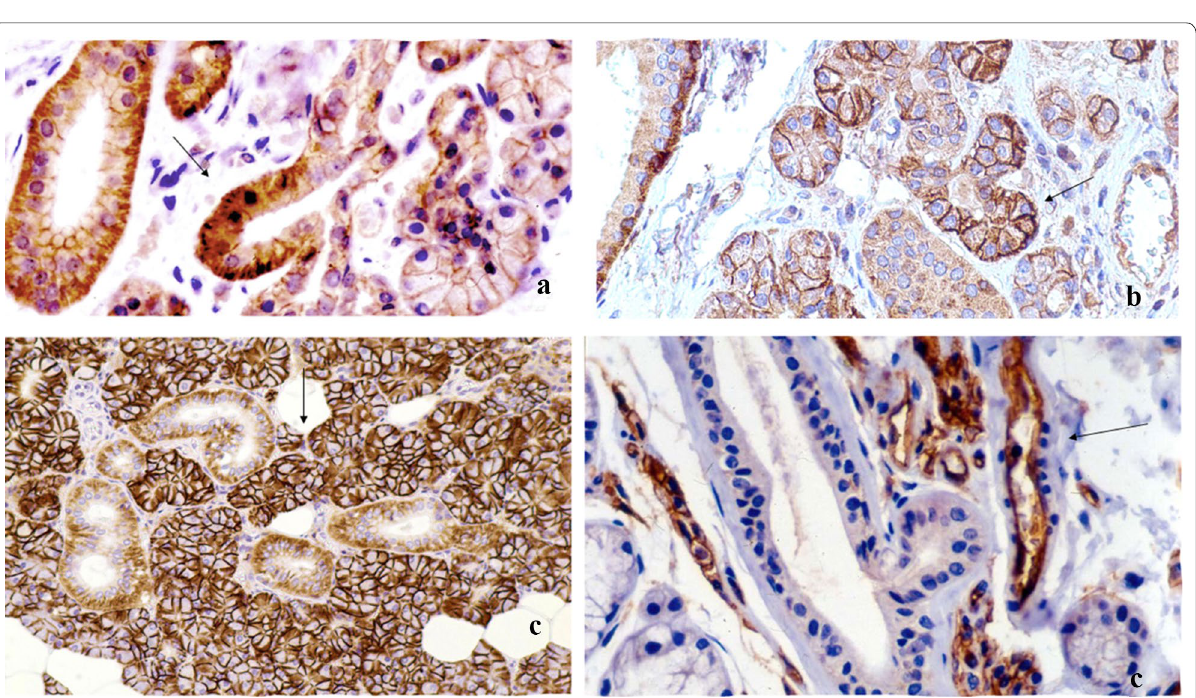
Fig. 1 Cell adhesion molecules in normal salivary gland tissue. a Desmoglein-2 (Dsg-2): Linear membranous staining of acinar and ductal cells. b Beta4-integrin: Strong immunoreactivity of basolateral portion of serous cell membrane and basal cells of interlobular ducts. c HCAM (CD44s): Strong membranous staining of acinar cells (mainly serous), decreased expression in basolateral surfaces of ductal basal cells and partially in stromal non-epithelial cell subpopulations. d ICAM-1: Negative staining of epithelial cells. Membranous staining of non-epithelial stromal subpopulations such as endothelium, lymphocytes and